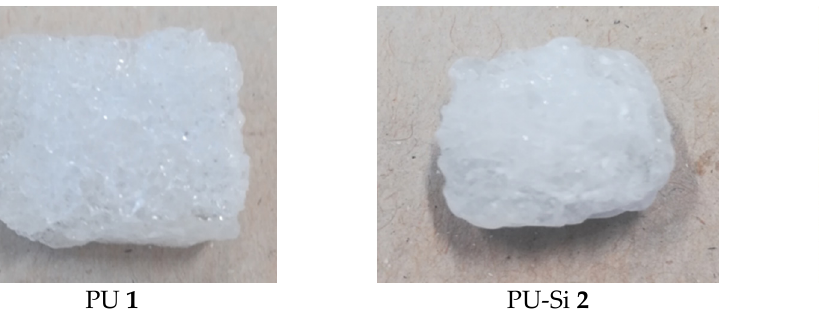
Figure 2. Photographs of polyurethane 1 and composite materials 2 and 3 .